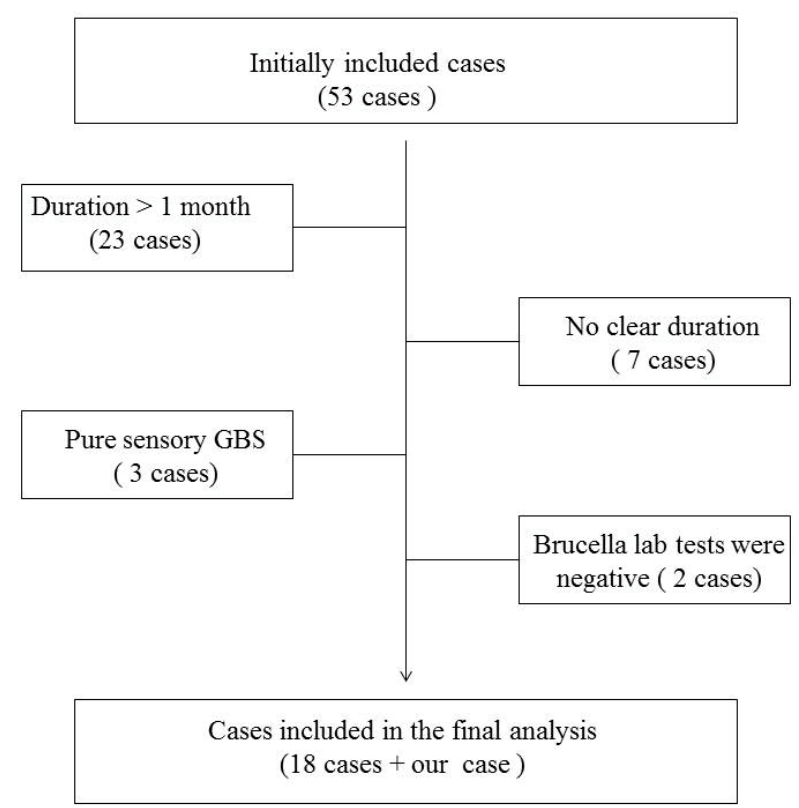
Figure 2. Flowchart demonstrating reasons for cases exclusion from the final anlaysis.